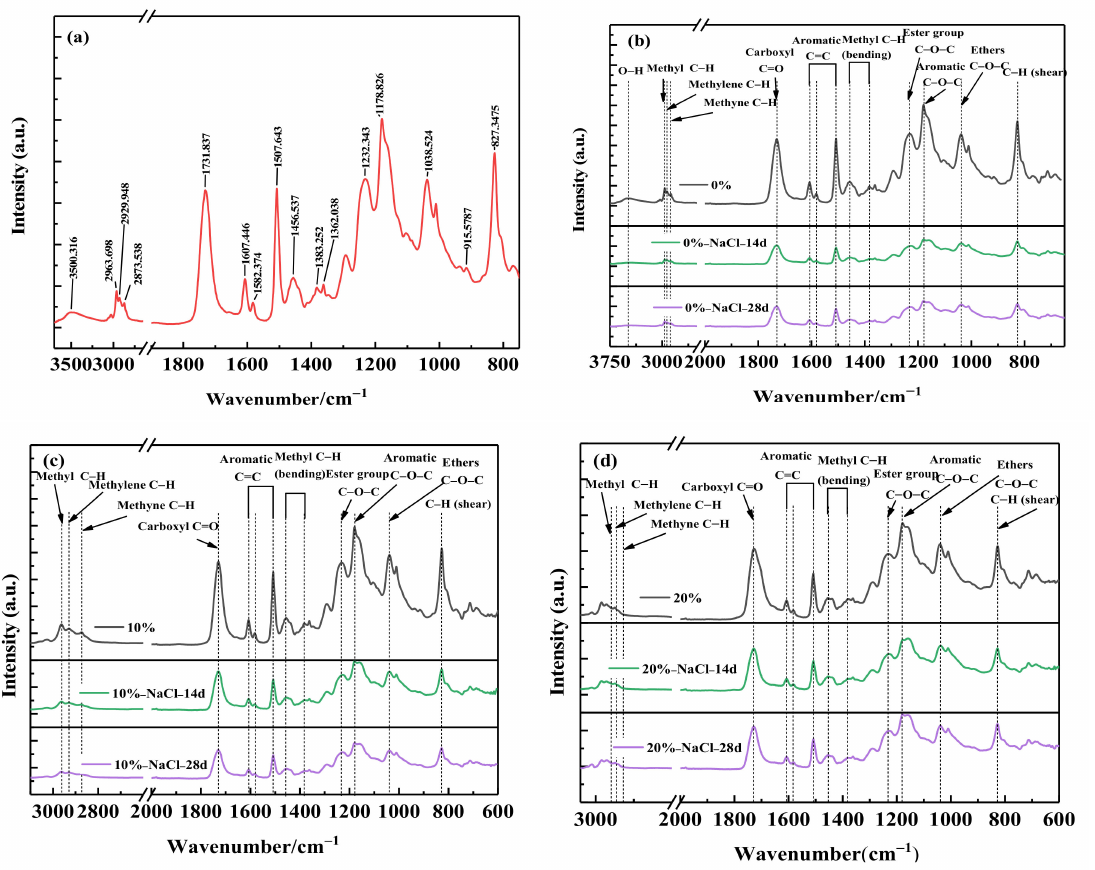
Figure 5. Infrared spectrum of ( a ) 10% 2021P/DGEBA, ( b ) 0% 2021P/DGEBA before and after aging, ( c ) 10% 2021P/DGEBA before and after aging, ( d ) 20% 2021P/DGEBA before and after